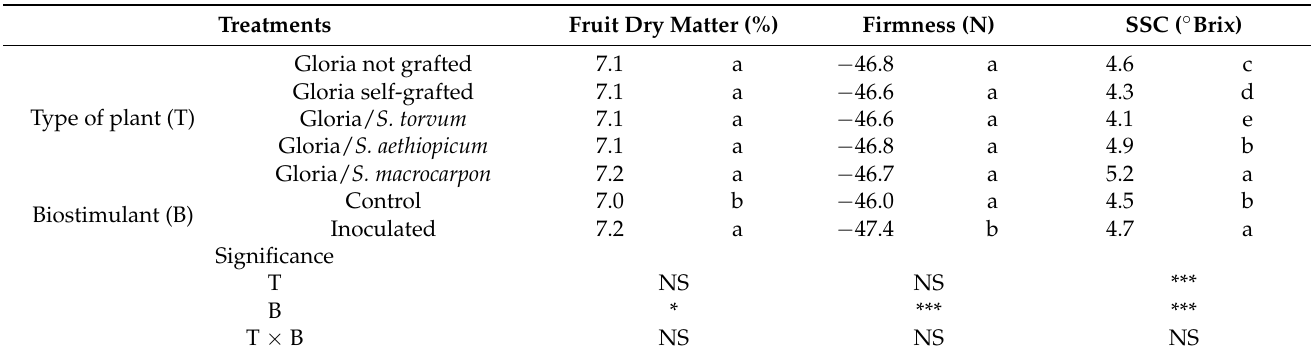
Table 2. Influences of the type of plant and biostimulant application on the fruit dry matter, firmness and soluble solids content (SSC) of